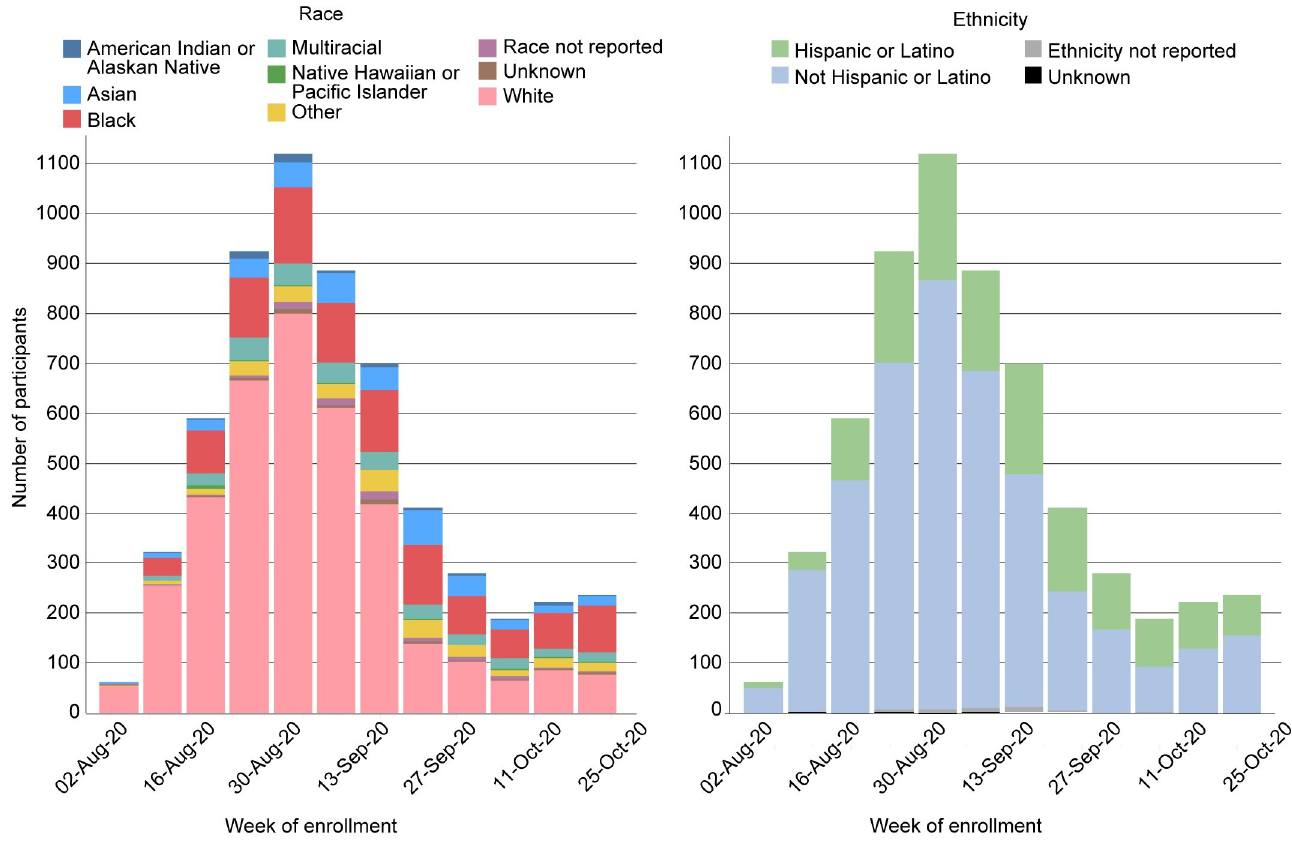
Fig 2. Moderna (Cove study) enrollment. (A) Counts reflect randomized